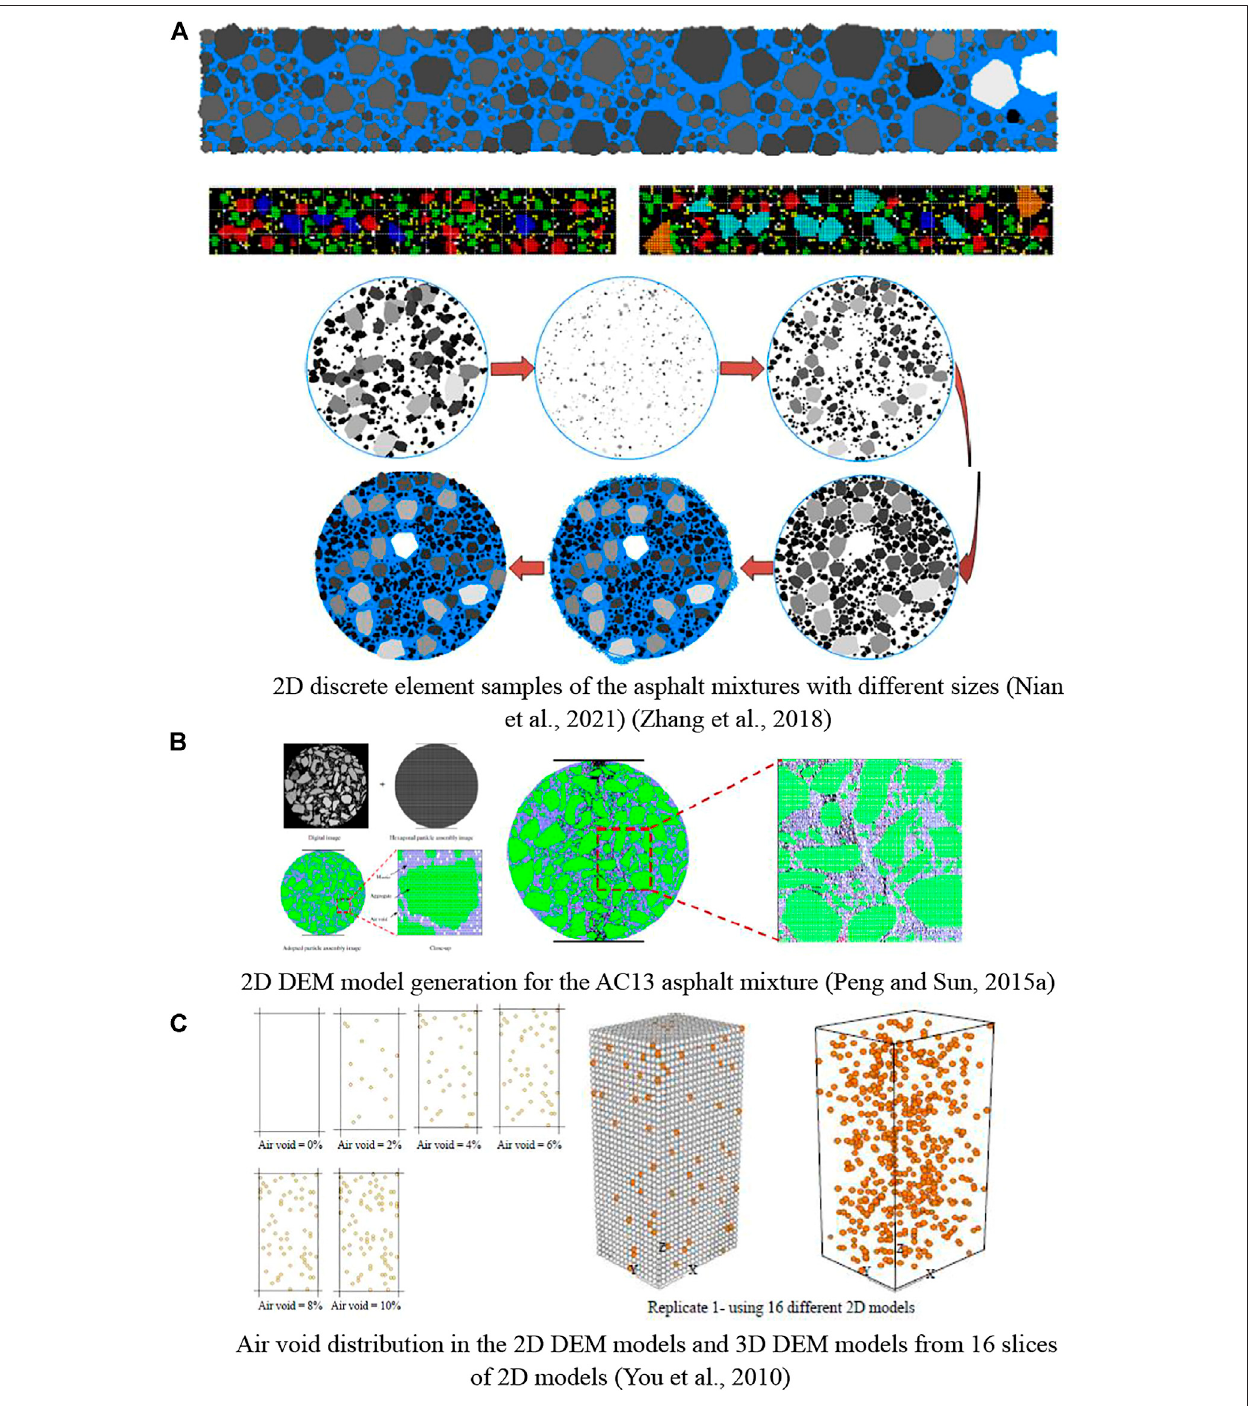
FIGURE 3 | 2D DEM samples with different gradation and air void distributions (Nian et al., 2021; Zhang et al., 2018; Peng and Sun, 2015a; You et al., 2010). (A) 2Ddiscreteelement samplesoftheasphaltmixtureswithdifferentsizes(Nianet al.,2021;Zhanget al.,2018). (B) 2DDEMmodel generationfortheAC13 asphaltmixture (Peng and Sun, 2015a). (C) Air void distribution in the 2D DEM models and 3D DEM models from 16 slices of 2D models (You et al., 2010).